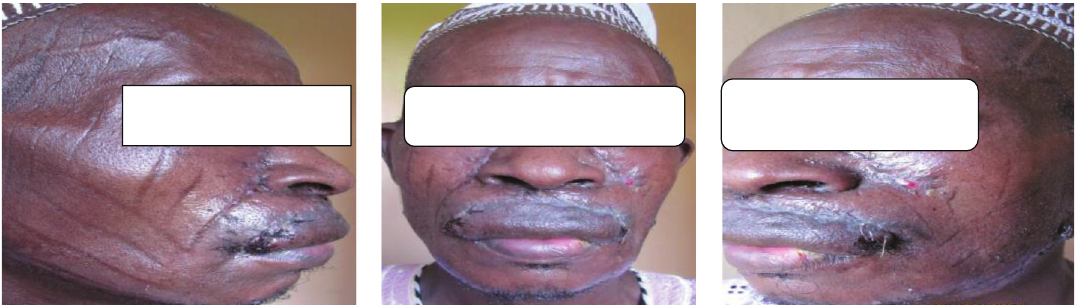
Figure 5: Postoperative picture views.